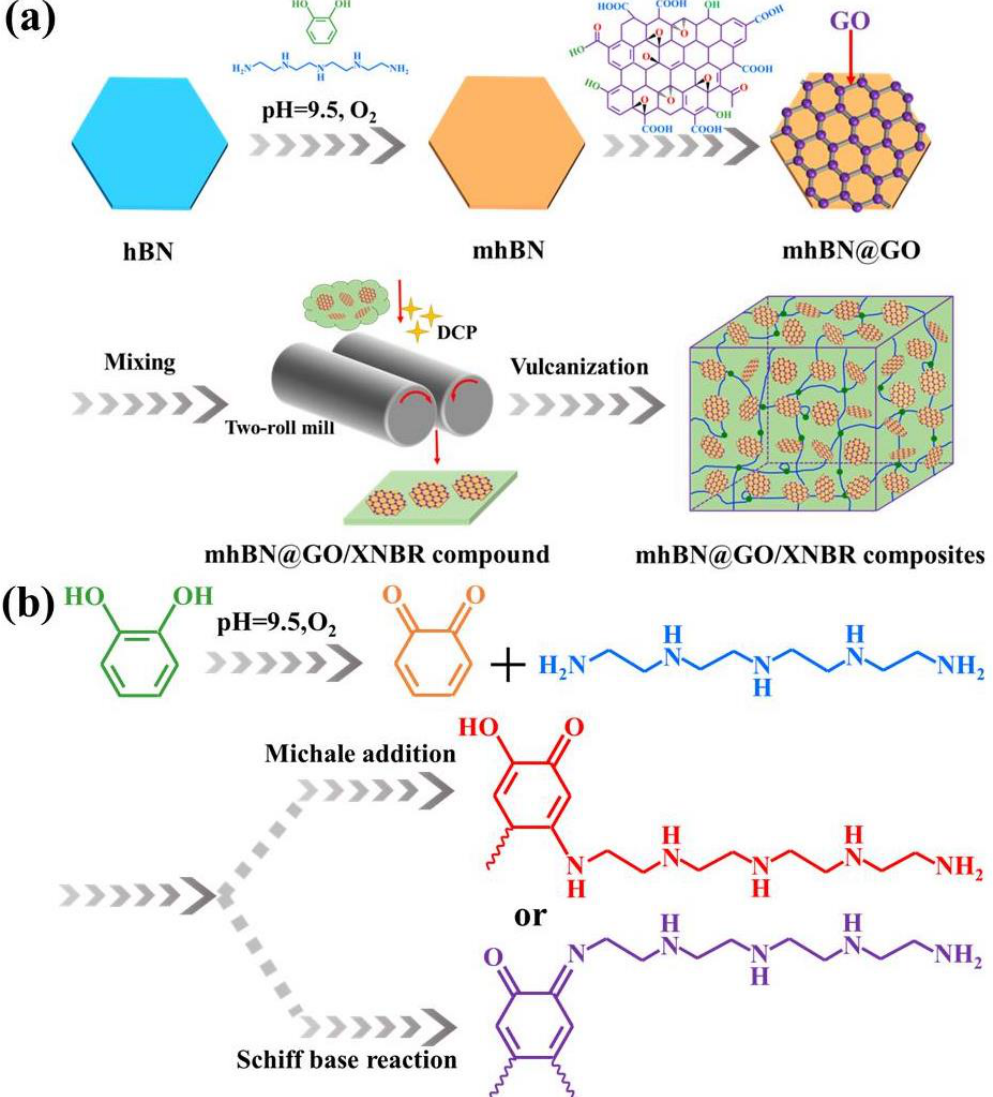
Figure 1. ( a ) Preparation of mhBN@GO hybrids and mhBN@GO/XNBR composites. ( b ) The reaction mechanism between catechol and tetraethylenepentamine.